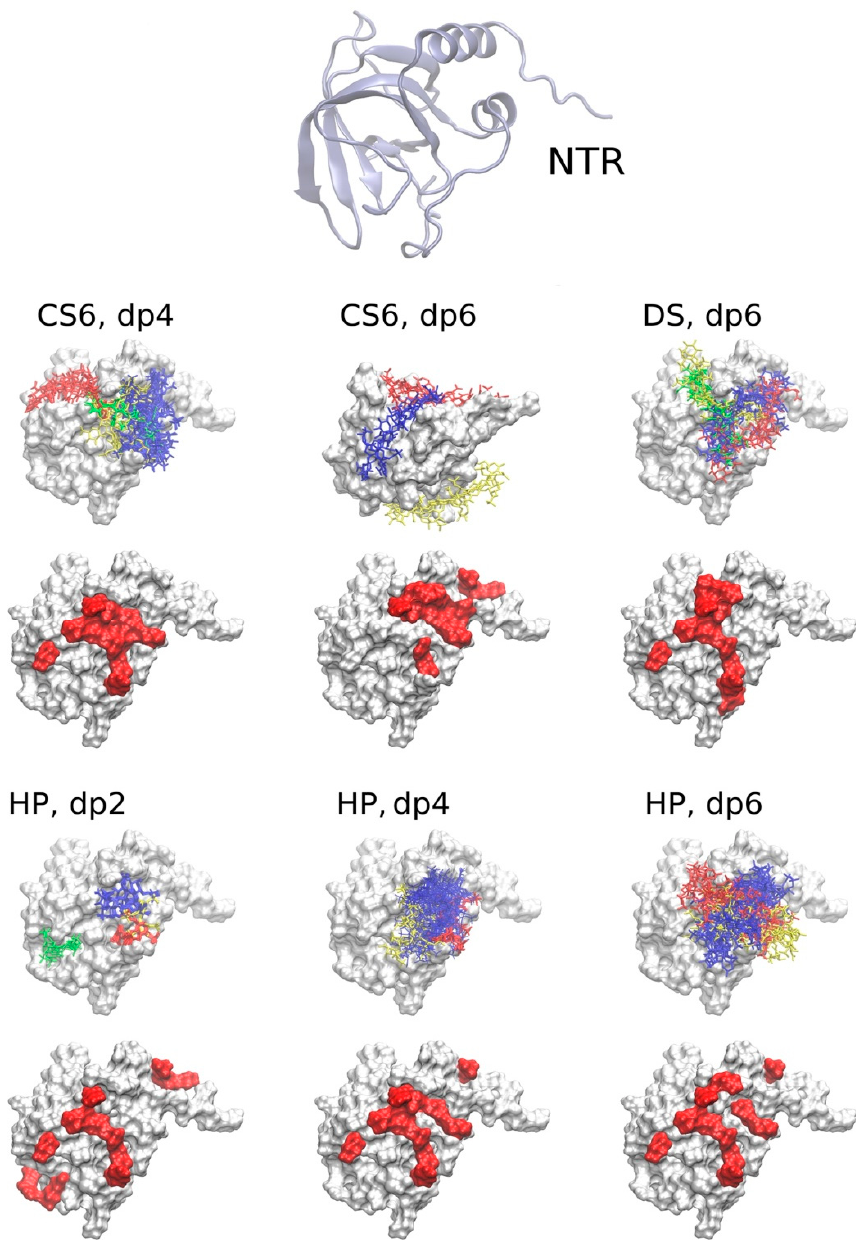
Figure 3. Molecular docking and molecular mechanics-generalized born surface area (MM-GBSA) for NTR-glycosaminoglycan (GAG) complexes. The structure of the NTR domain is shown in cartoon representation at the top. For each GAG, the analyzed clusters of docking solutions are shown in blue, red, yellow and green (from the most to the less populated cluster); the top 10 residues binding to GAGs according to MM-GBSA calculations averaged per GAG are highlighted in red surface. Note that the clusters for CS6 dp6 are shown for a different protein spatial orientation to allow for a better visualization. In addition, averaging the per-residue energy for very different clusters could be misleading as shown for CS6 dp6: the residues shown in red do not overlap with the surface patches where the most representative clusters of solutions are located.